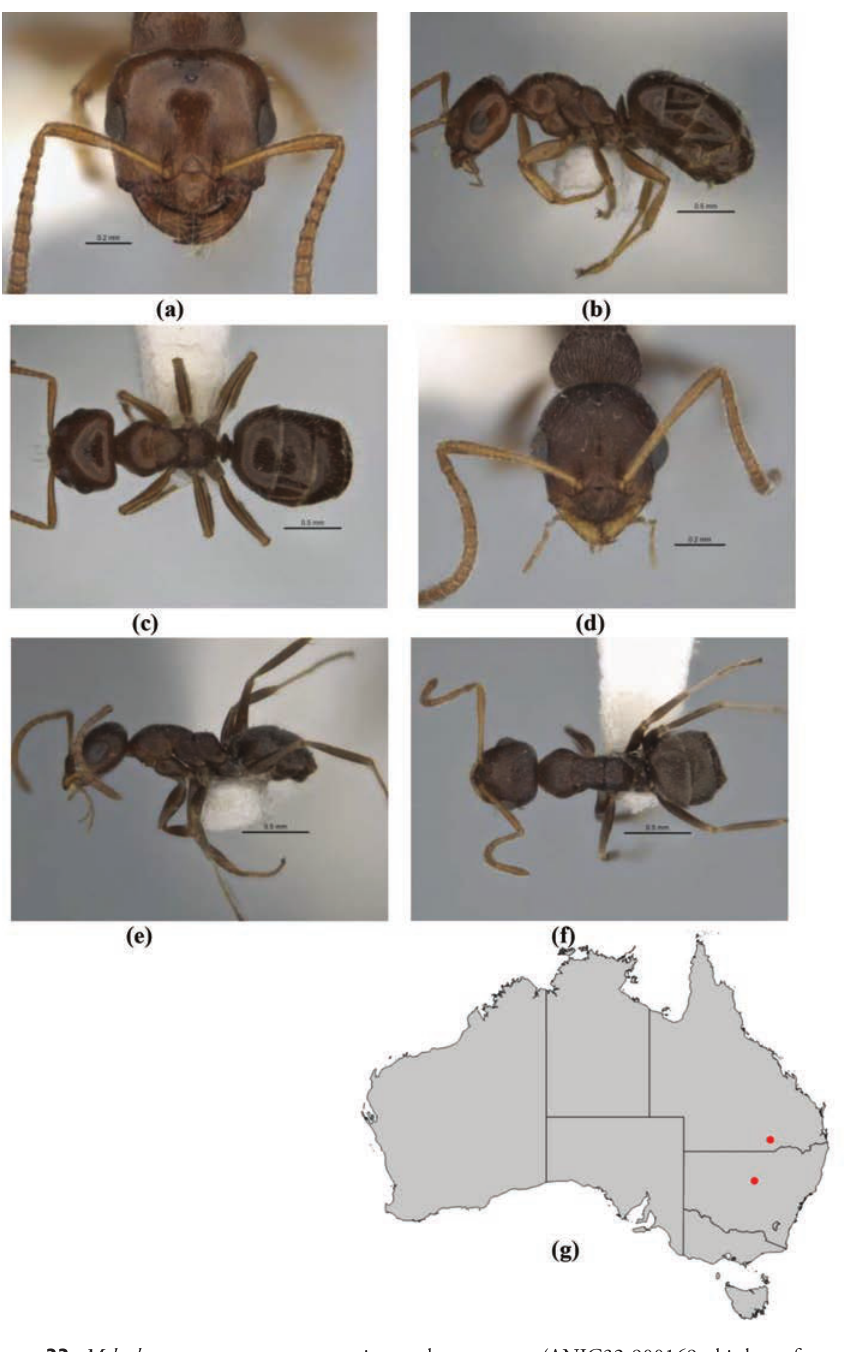
Figure 33. Melophorus compactus sp. n.: major worker paratype (ANIC32-900169–third ant from top) frons ( a ), profile ( b ) and dorsum ( c ); minor worker holotype (ANIC32-900088) frons ( d ), profile ( e ) and dorsum ( f ); distribution map for the species ( g ). Low resolution scale bars: 0.5 mm ( b, c , e, f ); 0.2 mm ( a, d